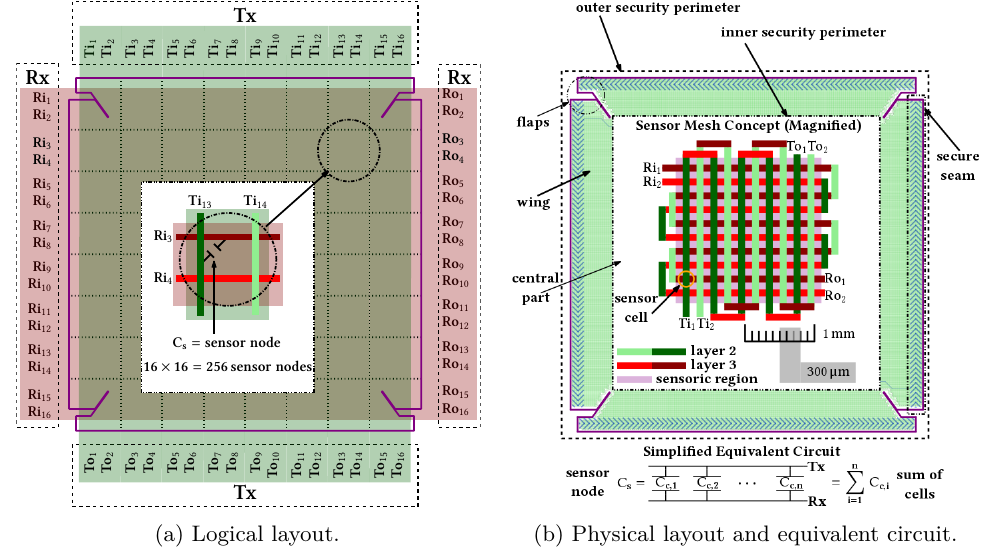
Figure 6: Different representations and details of the top